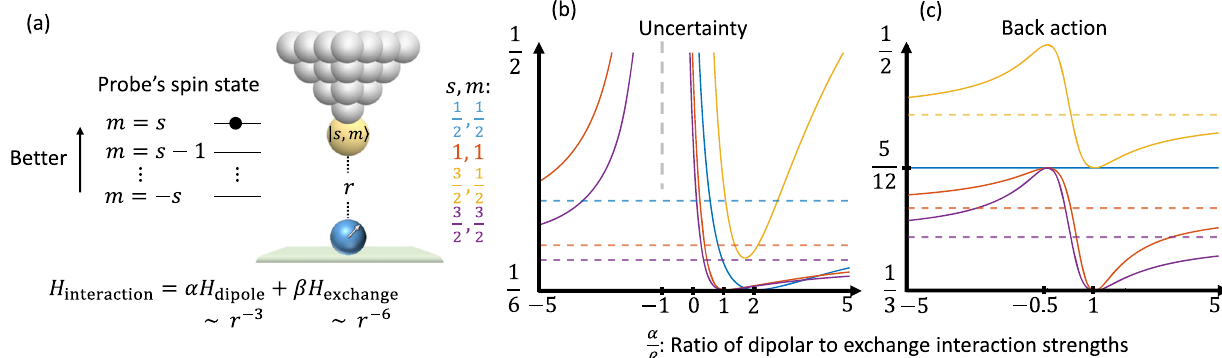
Fig. 4 Optimization of the quantum measurements by designing the source-probe interaction Hamiltonian. a An exchange interaction can optimize the measurement. The source-probe interaction Hamiltonian is a sum of dipolar and exchange interactions with strengths α and β (respectively), see Eq. (12). The coef fi cients α , β depend differently on the source-probe distance and have different coupling constants, thus their desired values are obtained by judicious design of a probe with certain electro-chemical properties, appropriate spin numbers s , m and by varying the source-distance r . b , c Results of numerical simulations: uncertainty (b) and back action (c) as a function of the interaction ratio α β , for different spin numbers s , m (see legend in (a)). Varying the source-probe interaction relative to solely dipolar interaction can improve the quantum measurement for any spin value: spin-1/2 (blue) yields optimal uncertainty for α β ¼ 2 , yet with the same suboptimal back action as in the dipolar case. Higher spin values (e.g., spin-1 in red and spin-3/2 in purple) yield fully optimal values of back action and uncertainty for α ¼ 1 , marked in green. This enables optimal measurement already with spin-1 particles without the need for higher spin values as seen in Fig. β 3. For a given value of s , higher m values are still favorable in both criteria, similarly to Fig. 3. Note the divergence of the uncertainties in the region (cid:2) 1 (cid:6) α β (cid:6) (cid:2) 1 , marked in (b) by gray dashed lines. The exact value of α β that yields a divergence depends on the spin values. This 2 divergence occurs due to vanishing mean-force range, as in Fig. 3 for m =